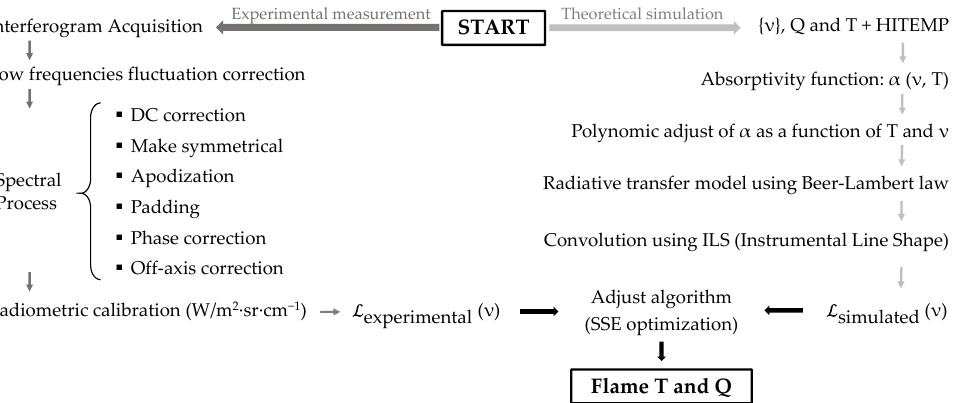
Figure 2. Scheme of the procedure to retrieve temperature and column density from hyperspectral measurements. Left : the stage of experimental measurement. Right : the stage of construction of simulated